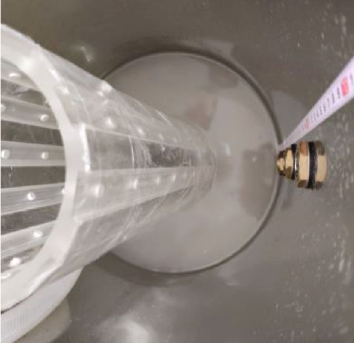
Figure 6: Schematic diagram of after water immersion.